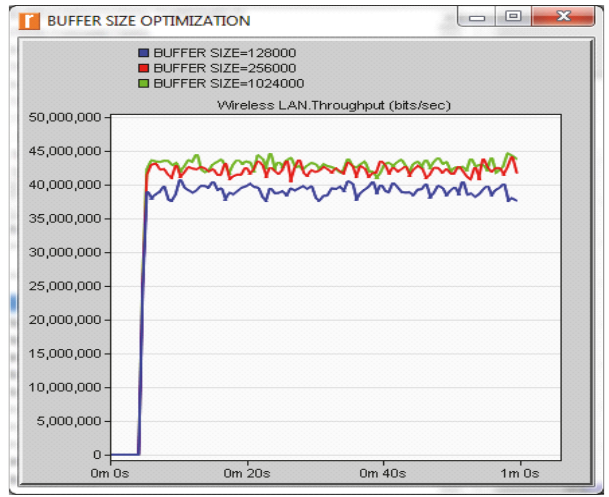
Figure 25: WLAN buffer size optimization for higher